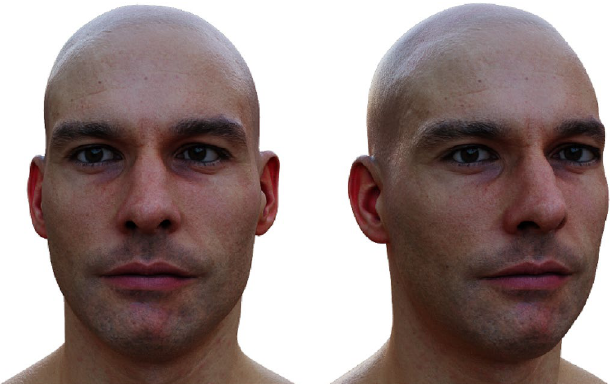
Figure 1. The Wollaston illusion, wherein identical sets of eyes (e.g., reflected in the iris position and amount of sclera visible) result in a different percept of gaze direction dependent upon the surrounding head orientation. The face images were generated with FaceGen Modeller 3.5., (https:// faceg en.